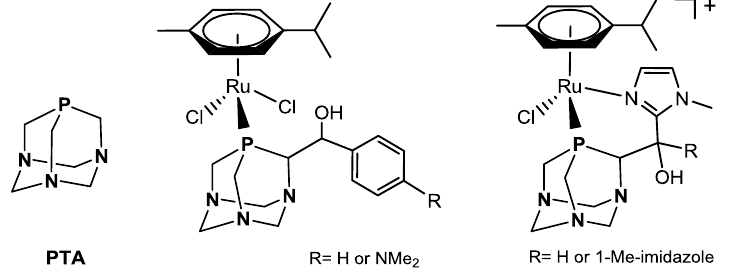
Figure 1. PTA ligand and Ru(II)-arene complexes bearing ‘upper rim’ PTA derivatives.